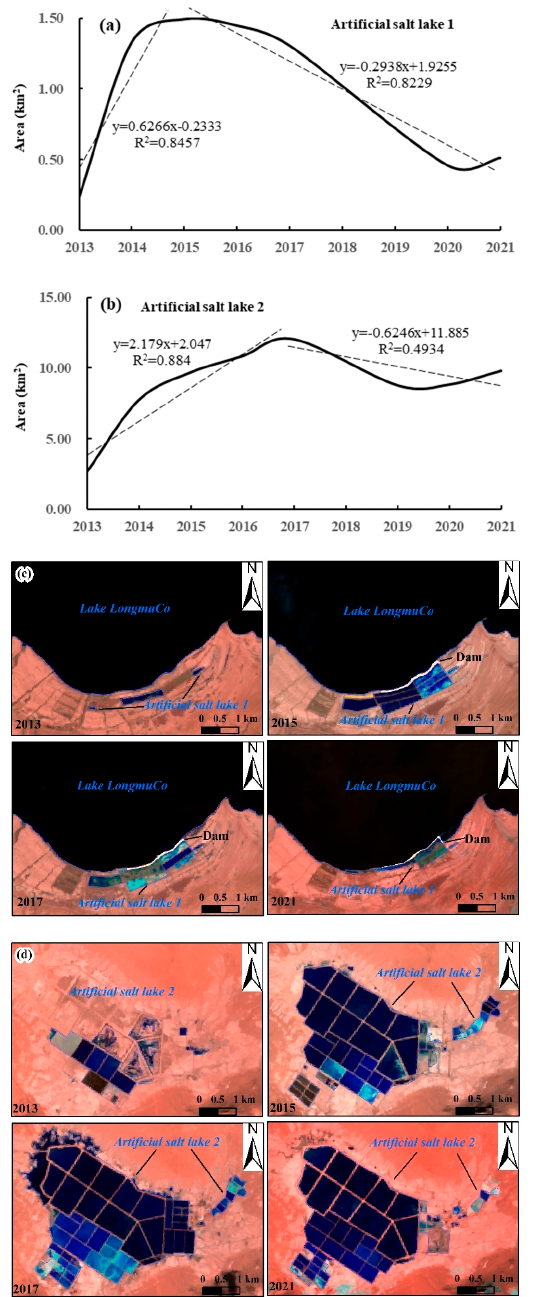
Figure 6. Area changes ( a , b ) and spatial distribution in different years ( c , d ) of the artificial salt lakes between 2013 and 2021.